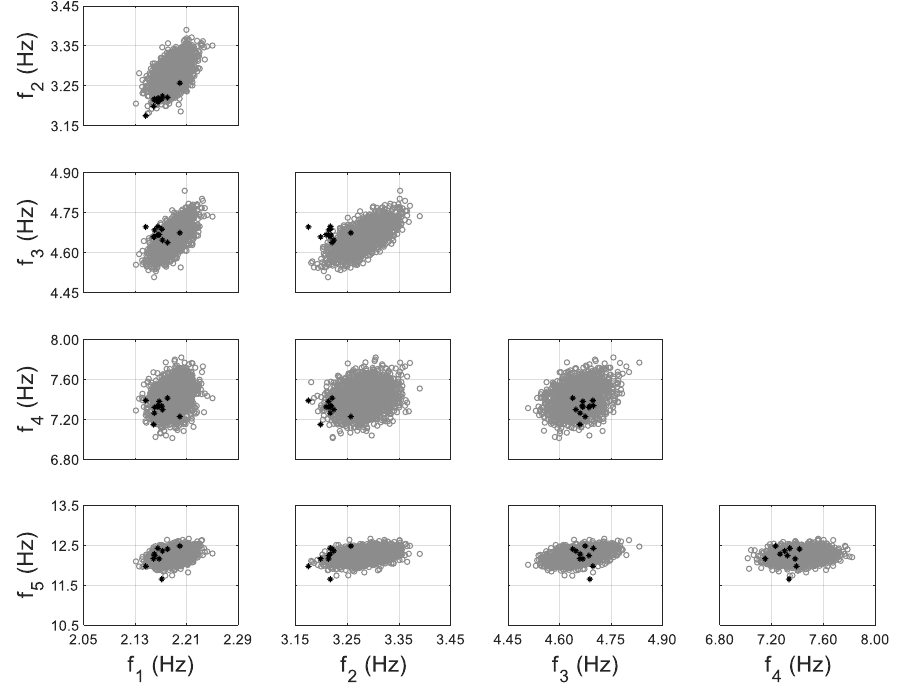
Figure 11. Model-predicted (with the propagation of error function) (gray) vs. identified (black) natural frequencies of the 10-story building at moderate damage state, considering non-zero-mean error function for 5th mode.